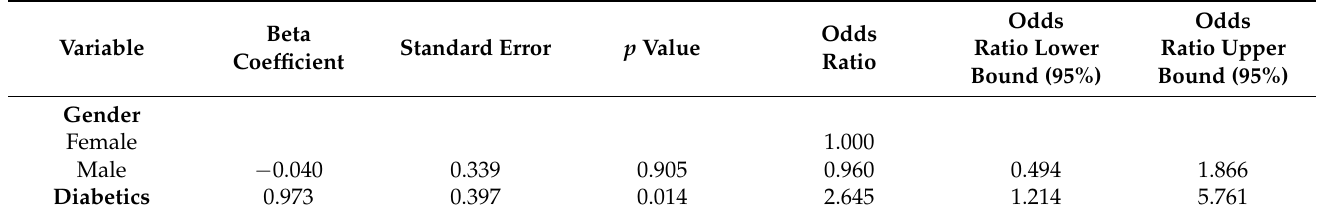
Table 2. Univariate logistic regression to identify significant risk factors of moderate/severe CTSS.